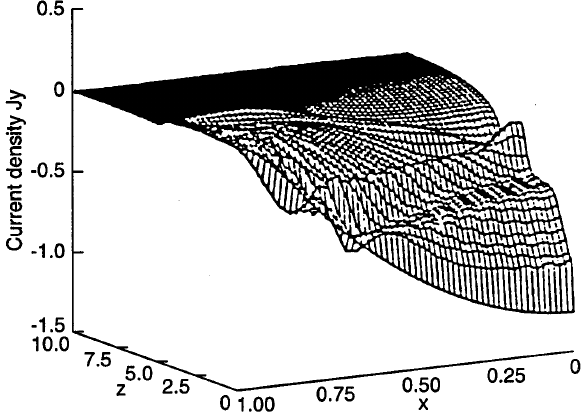
Fig. 1. 3-dimensional simulation of current sheet formation. Surface plot of the current density at y (cid:136) 0 being still almost smooth